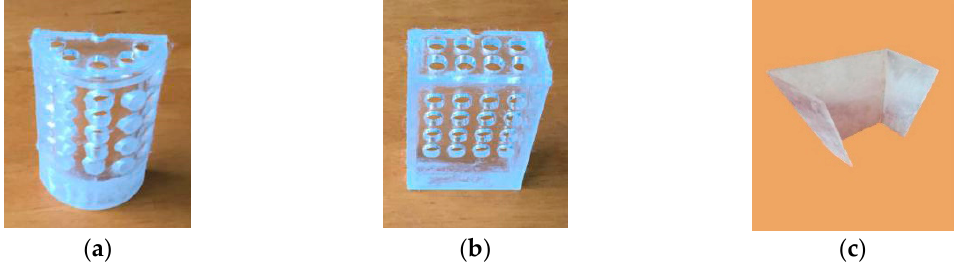
Figure 5. Arrangement of the piezometric tubes at the bottom of the recharge equipment.